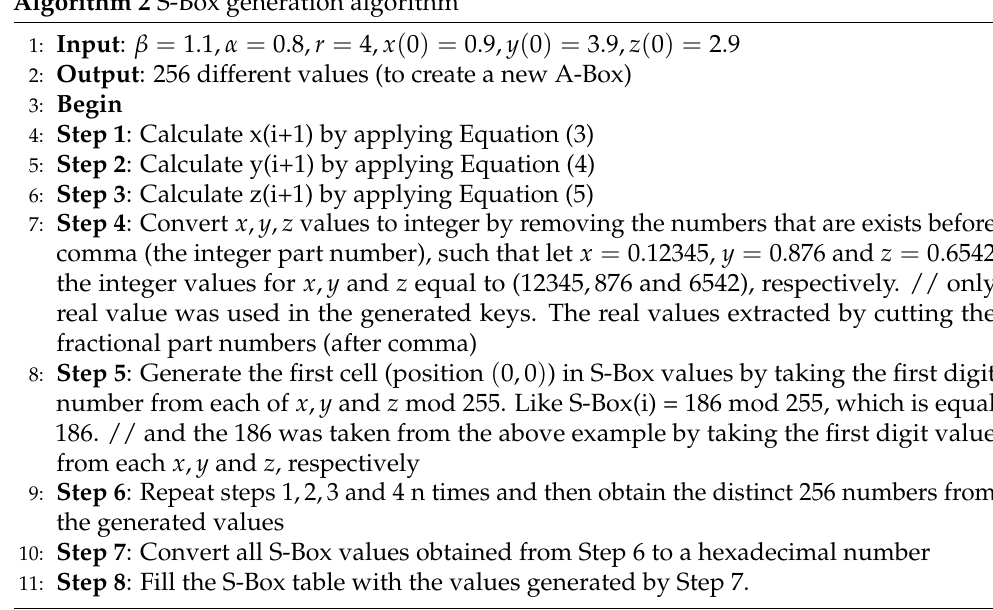
Algorithm 2 S-Box generation